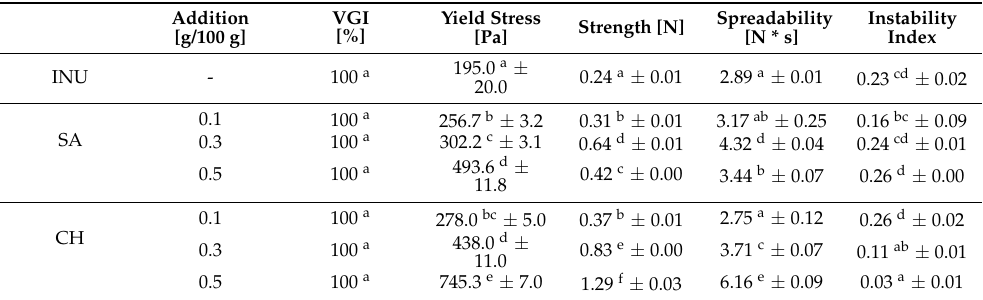
Table 1. Effect of sodium alginate (SA) and chitosan (CH) addition on the physical properties of inulin